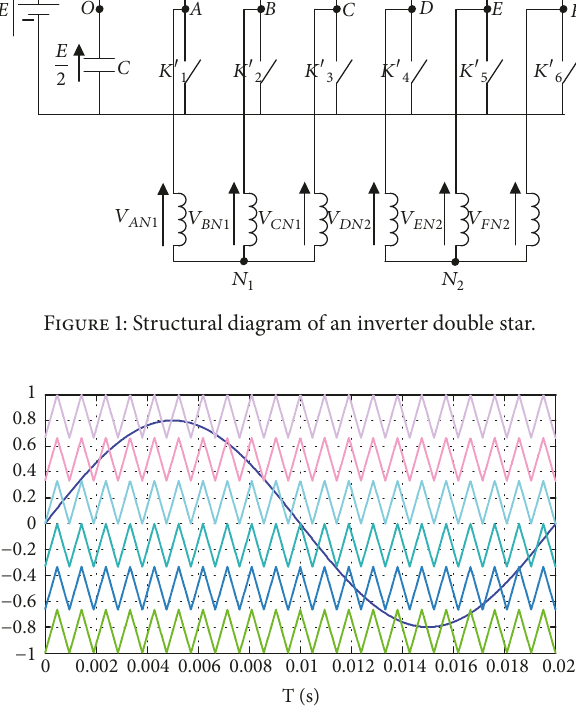
Figure 2: Principle of PWM technique (multicarrier PWM tech- nique) for a seven-level inverter.